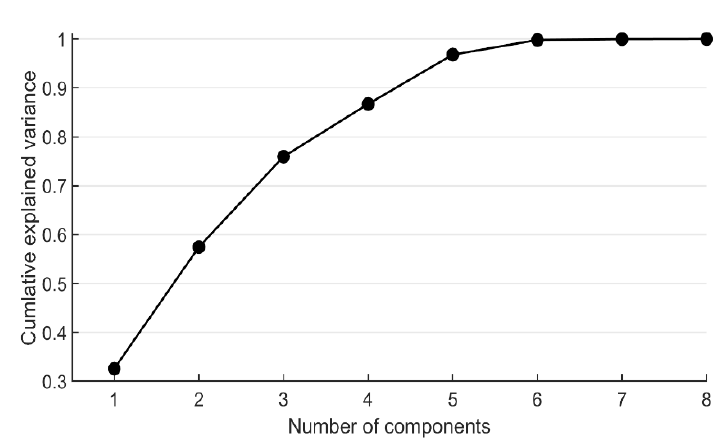
Figure 2. Cumulative explained variance ratio with respect to number of dimensions (PCA).